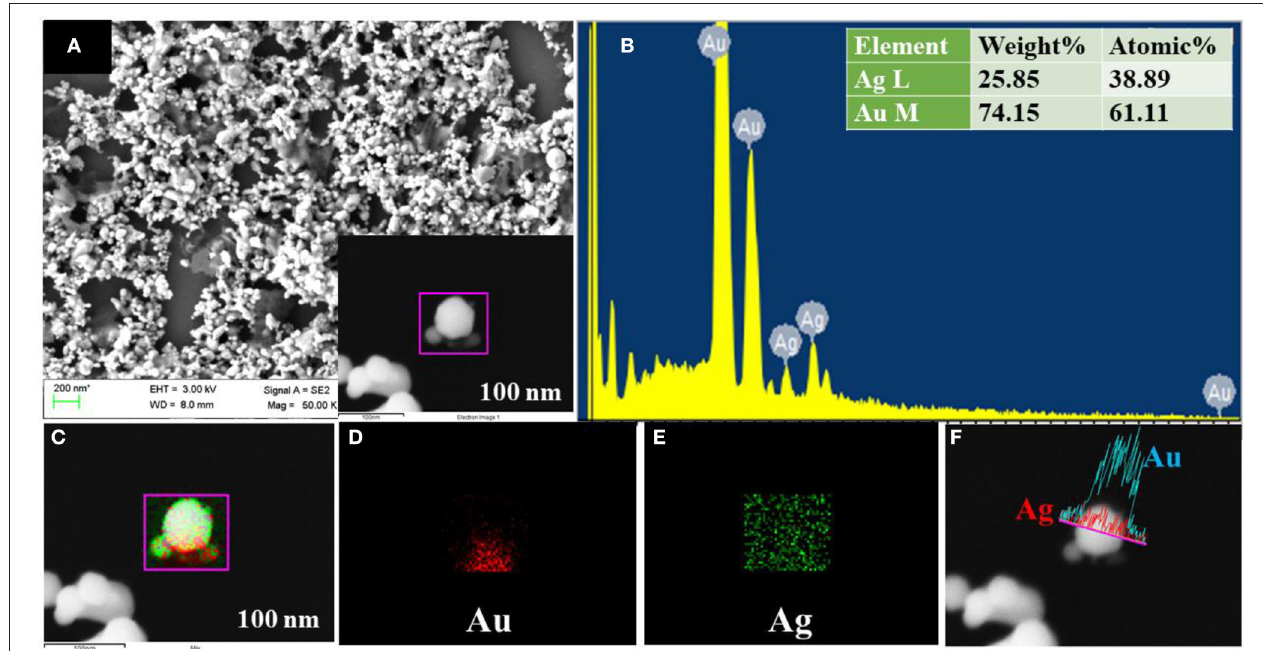
FIGURE 4 | (A) FESEM image of Ag@Au NPs with the inset illustrating the single NP image in the 100nm scale. (B) EDS spectra with inset depicting the wt % of individual elements. (C) EDS mapping image of the Ag @Au NPs. (D) Au EDS map. (E) Ag EDS map. (F) Line profile of the Ag@Au particle clearly demonstrating the presence of both.